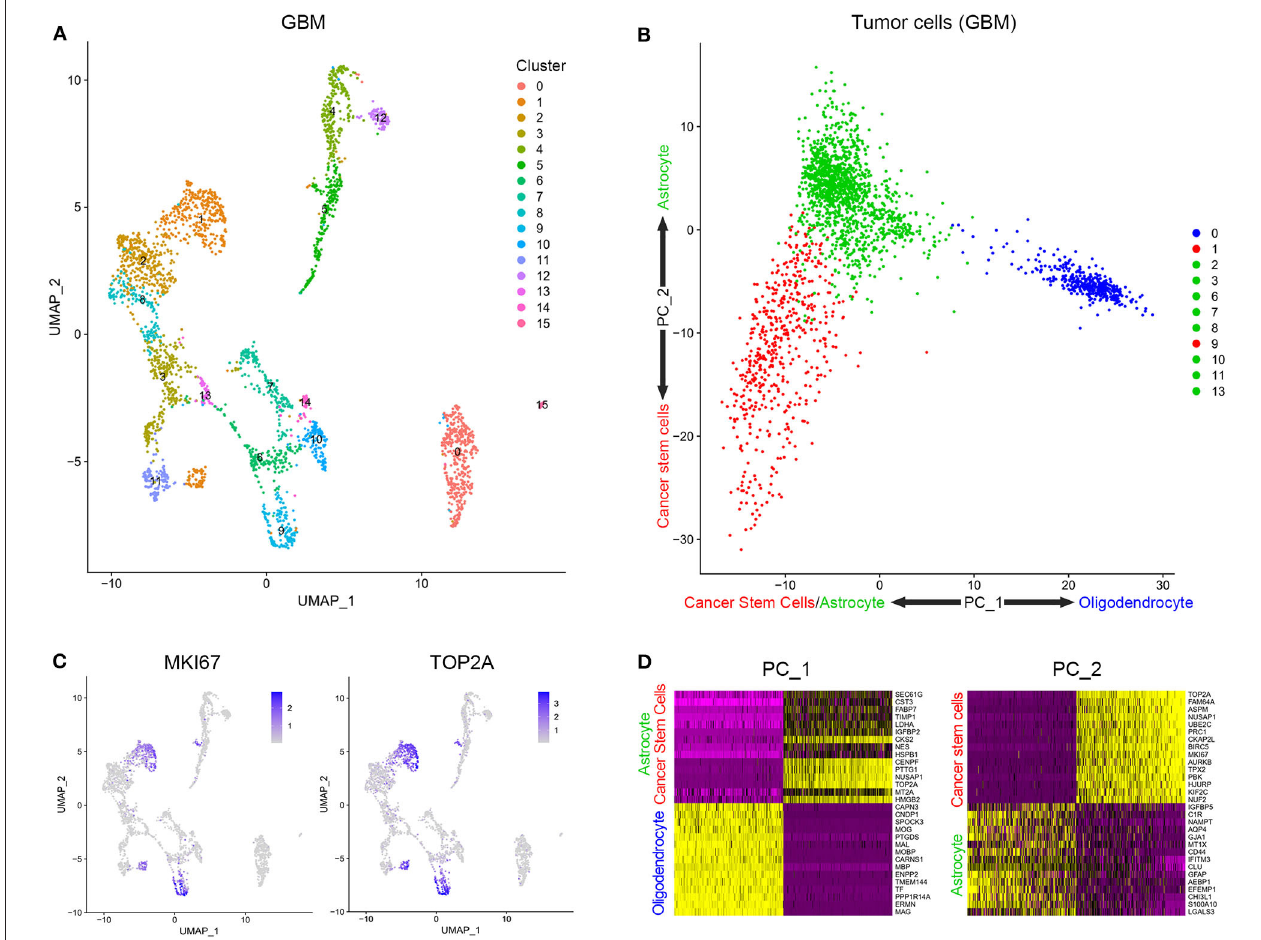
FIGURE 1 | Stratification and identification of cells from surgical specimens. (A) The subgroups of cells in surgical specimens. (B) The expression level of proliferation-associated biomarkers in different cell subgroups. (C) The PCA analysis of tumor cells in surgical samples. (D) Genes related to PC1 and